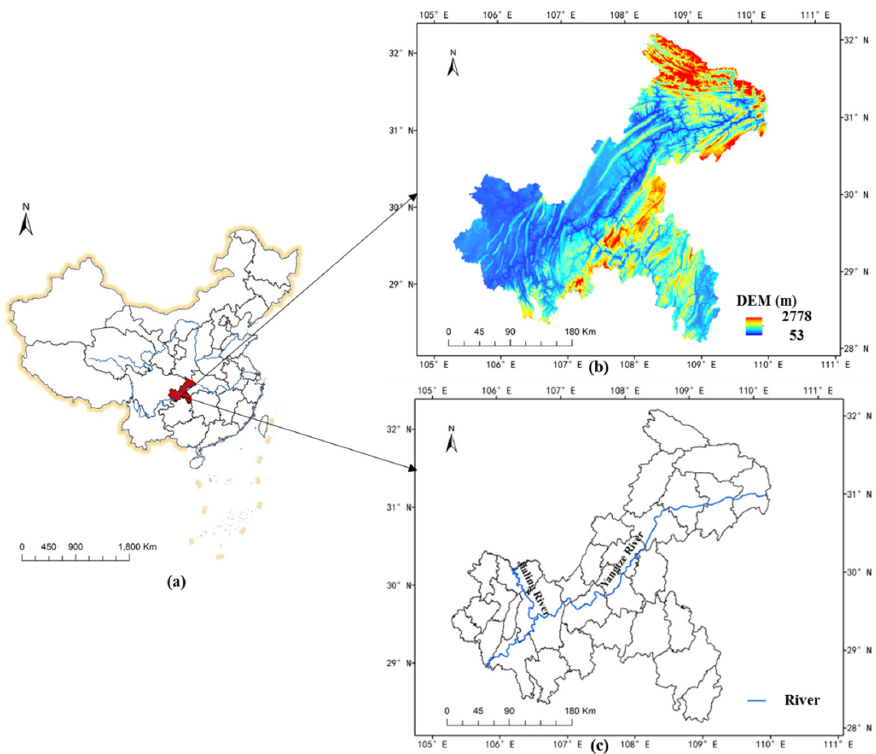
Figure 1. Location ( a ), digital elevation model (DEM) ( b ), and rivers ( c ) of the study area.